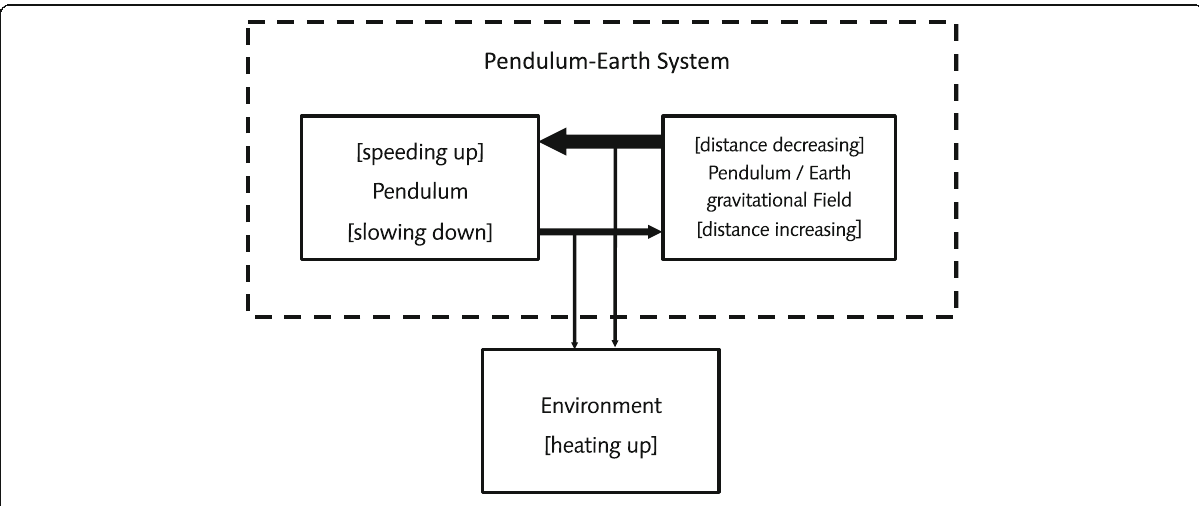
Fig. 4 ETM for a pendulum swinging in air. Arrow thickness represents relative rates of energy